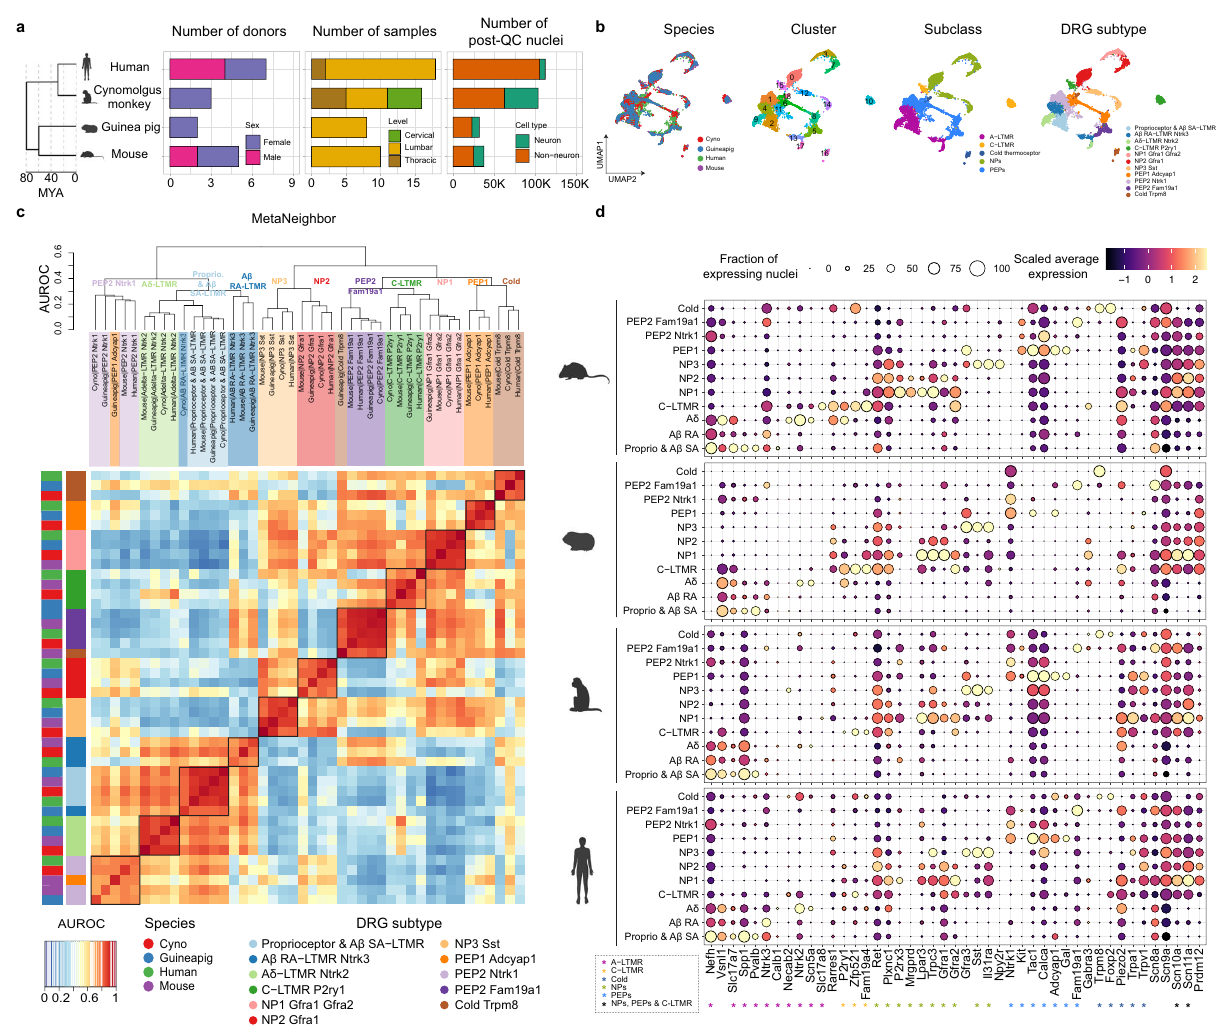
Fig. 3 | DRG sensory neuron homology consensus across mouse, guinea pig, cynomolgus monkey and human. a Summary metrics for mouse, guinea pig, cynomolgus monkey, and human DRG single-nuclei RNA-seq data. Evolutionary distances (Million Years Ago; MYA) are shown in the dendrogram to the left. b UMAP of Seurat-integrated DRG neurons across mouse, guinea pig, cynomolgus monkey, and human, faceted and colored by species, Seurat clusters, DRG sub- classes, and subtypes. c Cross-species dendrogram and heatmap of MetaNeighbor mean area under the receiver operator characteristic (AUROC) scores ( y -axis in